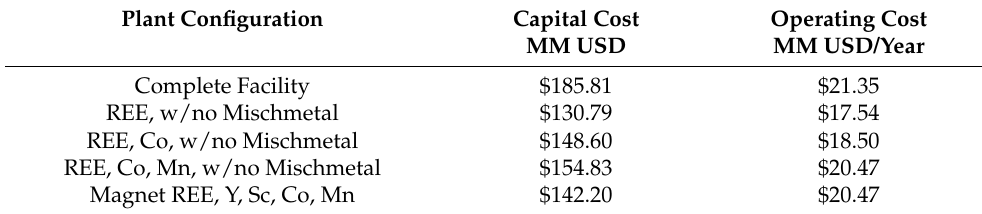
Table 6. Capital and operating cost summary.